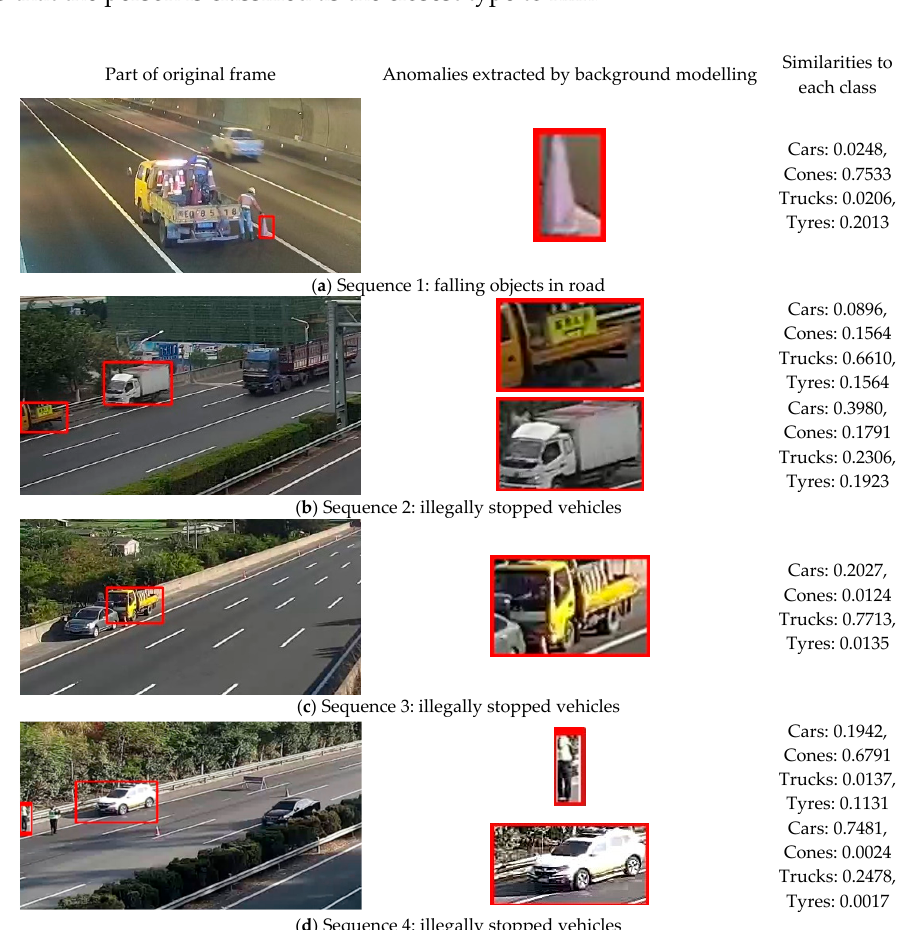
Table 2. Performances comparison of the three methods.